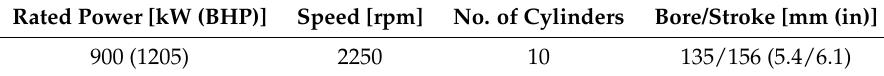
Table 1. Diesel engine specification for Thames Clippers vessel: MTU 10V 2000